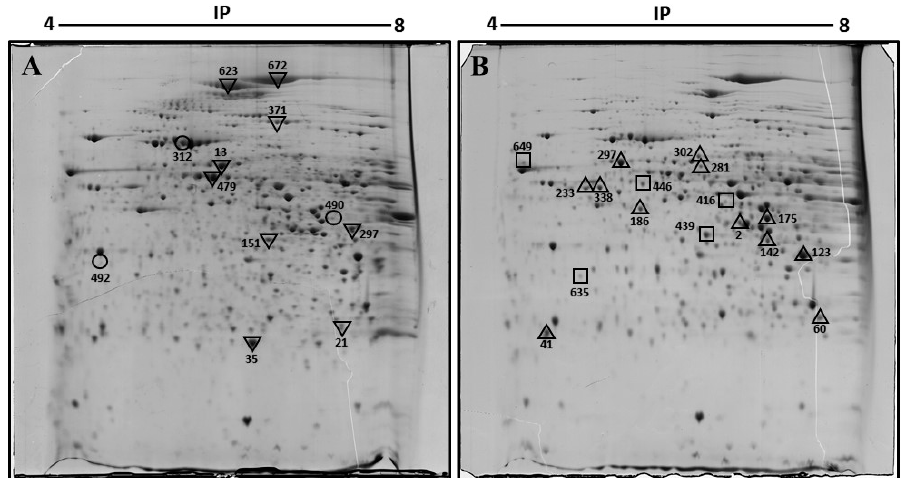
Figure 1. Representative two-dimensional electrophoresis image of the liver of control ( A ) and diabetic obese db/db ( B ) mouse. Proteins were separated by isoelectric focusing (IEF) in the first dimension, pH 4–8 Linear, then by size in the second dimension. Spots found with differential expression are marked in the gels. In ( A ): , diminished proteins in db/db mice. ○ , disappeared proteins in db/db mice. In ( B ): Δ , increased proteins in db/db mice. □ , appeared proteins in db/db mice liver. Spots 233 and 338 were the same protein, keratin, type I cytoskeletal 18. The spots were excised from the gel, digested with trypsin, and identified by mass spectrometry. The results are shown in Table 1. Comprehensive analysis revealed that 29 spots registered a significant difference in diabetic hepatic tissue, 26 proteins were identified. Note that two spots were identified as the same protein, and that the identity of 3 spots could not be obtained. Of the 26 proteins identified, 12 protein spots were up-regulated and 8 were down-regulated in the liver samples of db/db mice compared with those of healthy mice. In addition, three spots appeared de novo, and in three other spots, expression was no longer detected in db/db mice. Table 1. Proteins differentially expressed in the db/db mouse liver.